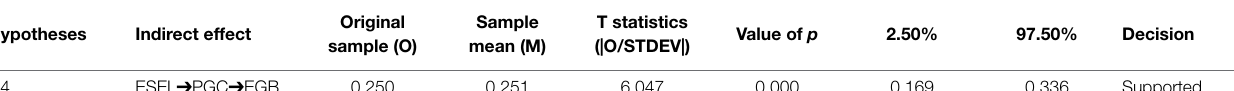
TABLE 12 | Result of mediation hypotheses (indirect effects).